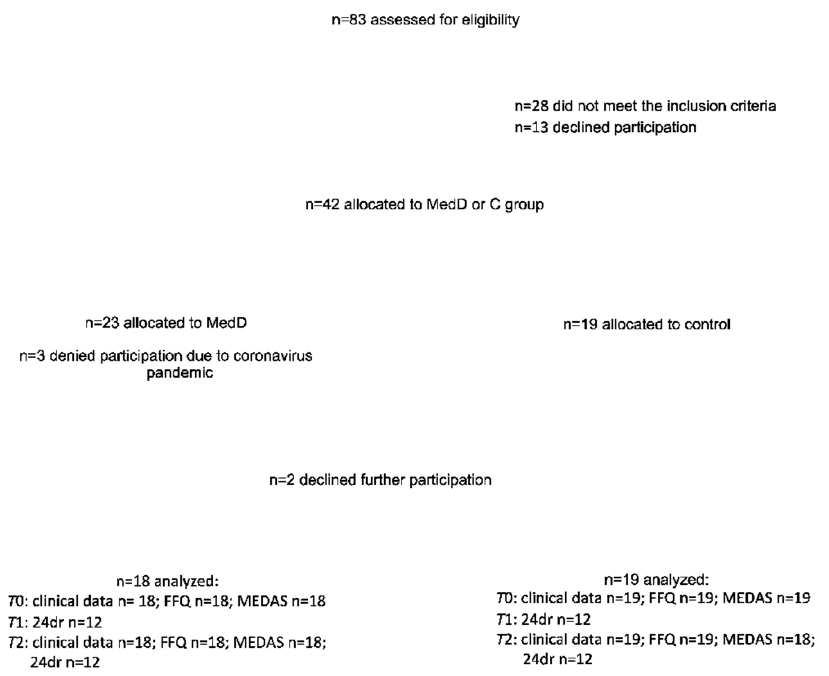
n=83 assessed for eligibility